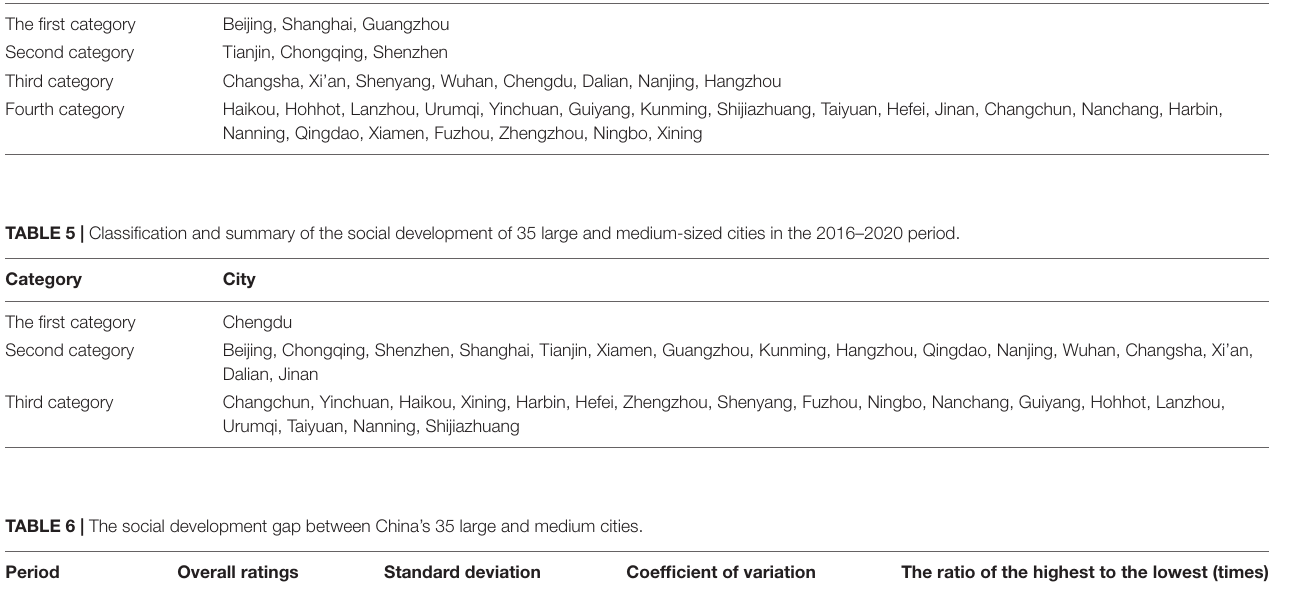
TABLE 6 | The social development gap between China’s 35 large and medium cities. Period Overall ratings Standard deviation Coefficient of variation The ratio of the highest to the lowest (times)